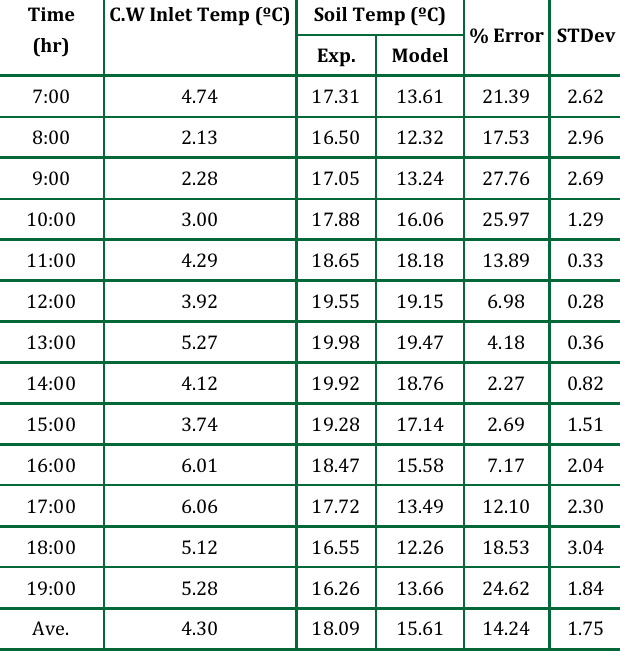
Table 2: Experimental and model soil temperature comparison